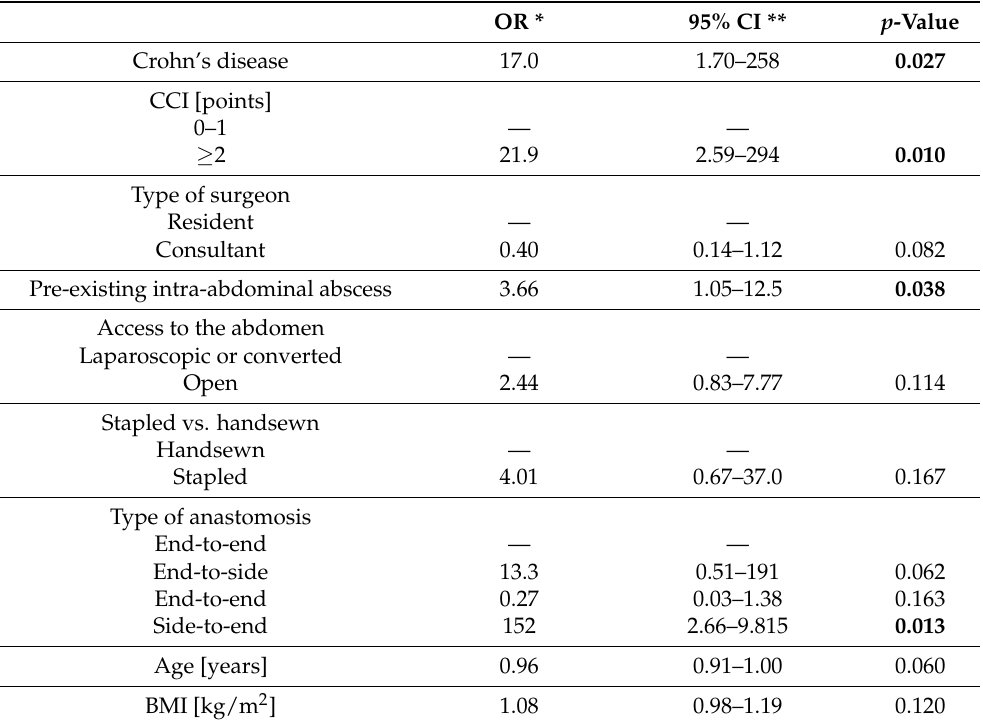
Table 5. Final logistic regression model after Akaike information criterion (AIC)-based forward variable selection. p -values are conditional on the final model specification.